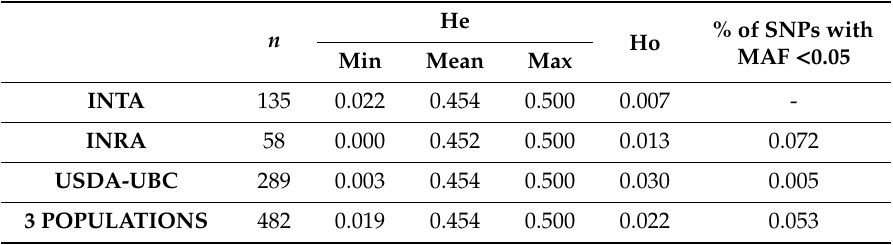
Table 1. Basic genetic diversity estimates within breeding